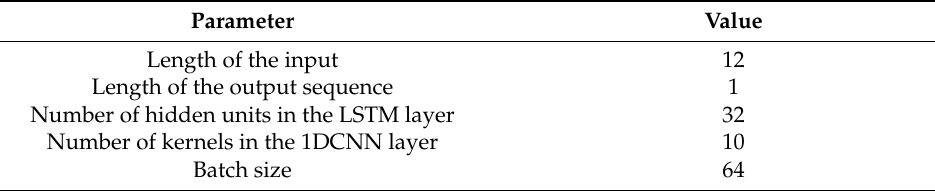
Table 3. Main parameters of the TPA–LSTM.